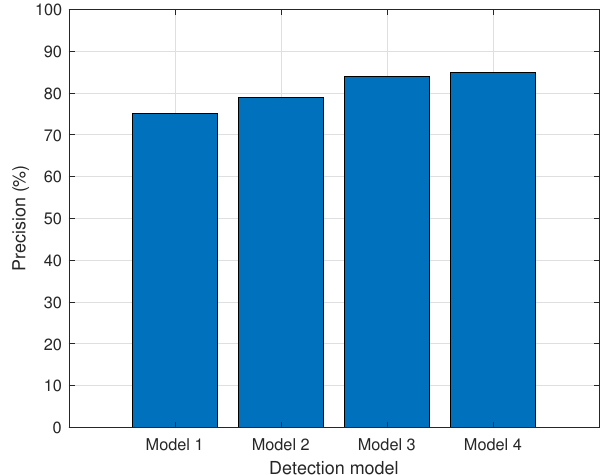
Figure 2. Precision for each recognition model.